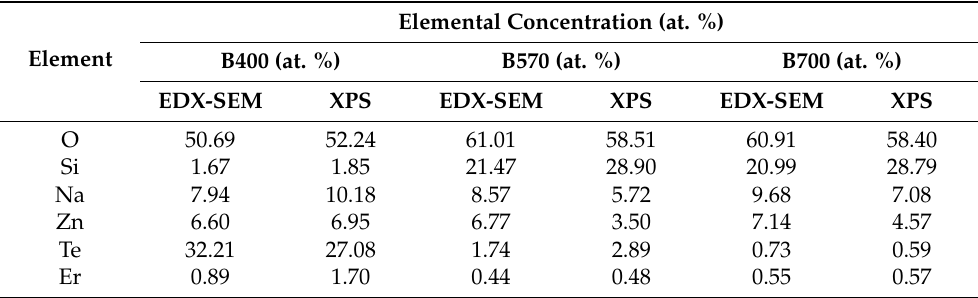
Table 2. Percentage of components existing in the upper layer of SOS substrate for samples fabricated using different substrate temperatures obtained from EDX-SEM and